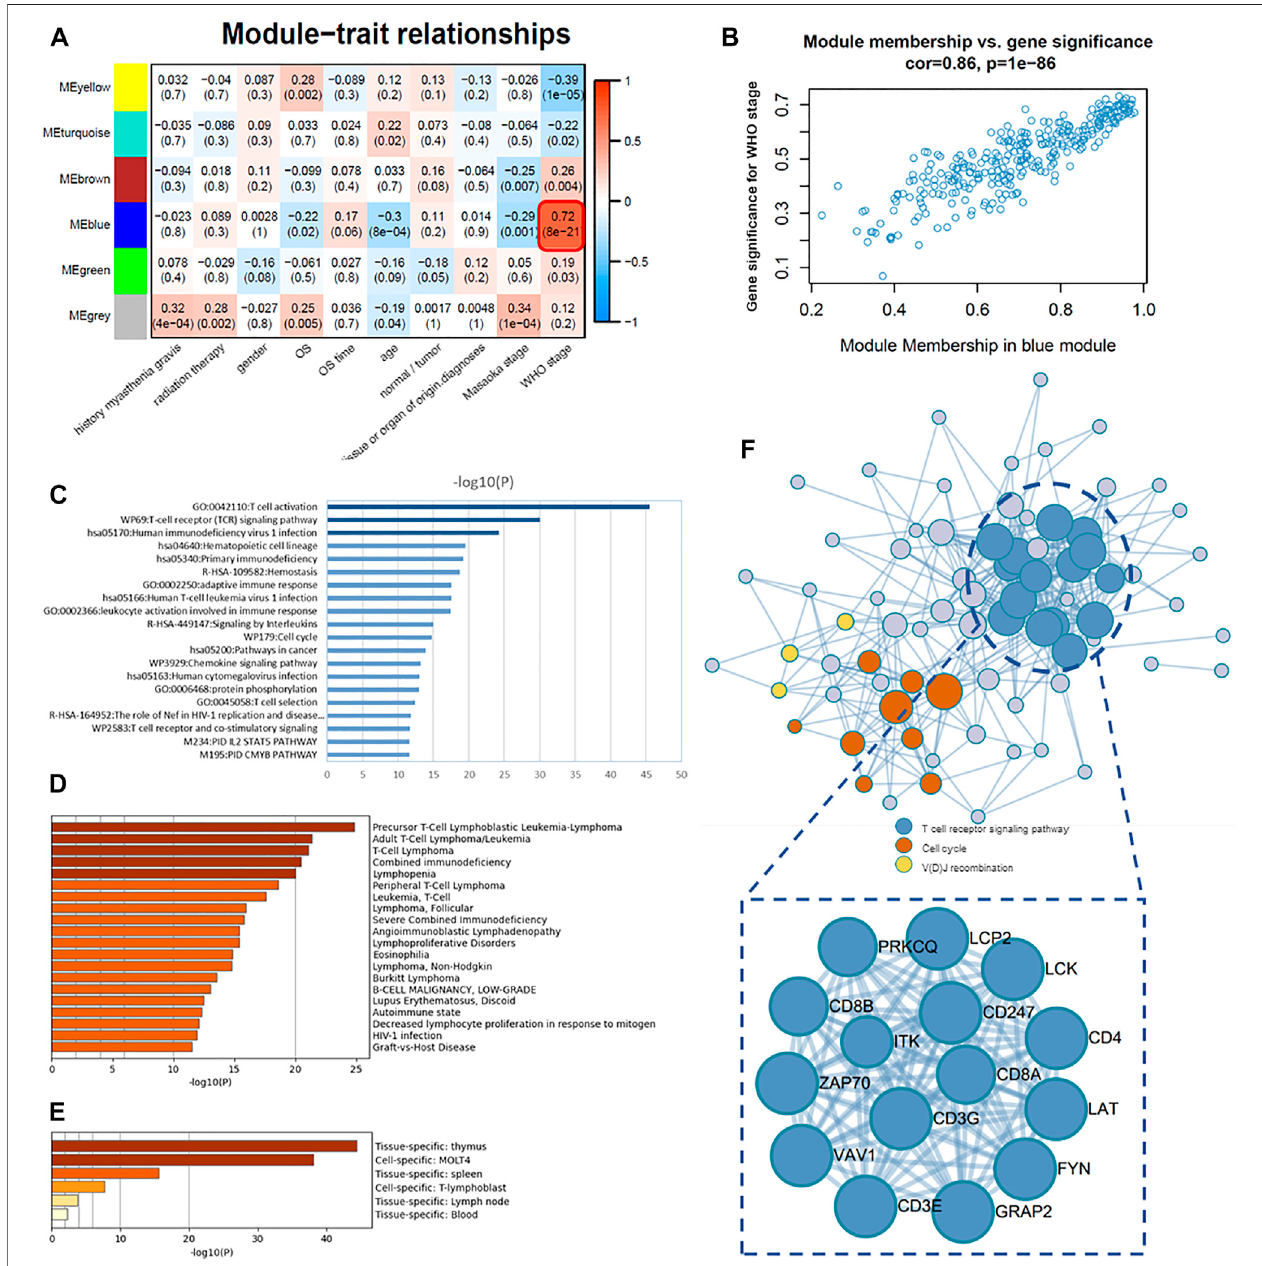
FIGURE 5 | Association of modules with clinical traits and determination of core genes. (A) Module – trait associations: each row corresponds to a module eigengeneand each column toa trait. Each cell contains the correspondingcorrelation and p -value. (B) Scatter plots ofGS score and MM for genesin the blue module. (C) Pathway and process enrichment analysis: bar graph of enriched terms across 87 core genes (intramodular connectivity > 0.7) in the blue module, colored by p -values. (D) Summary of enrichment analysis in DisGeNET, colored by p -values. (E) Summary of enrichment analysis in PaGenBase, colored by p -values. (F) Protein – protein interaction (PPI) network of 87 core